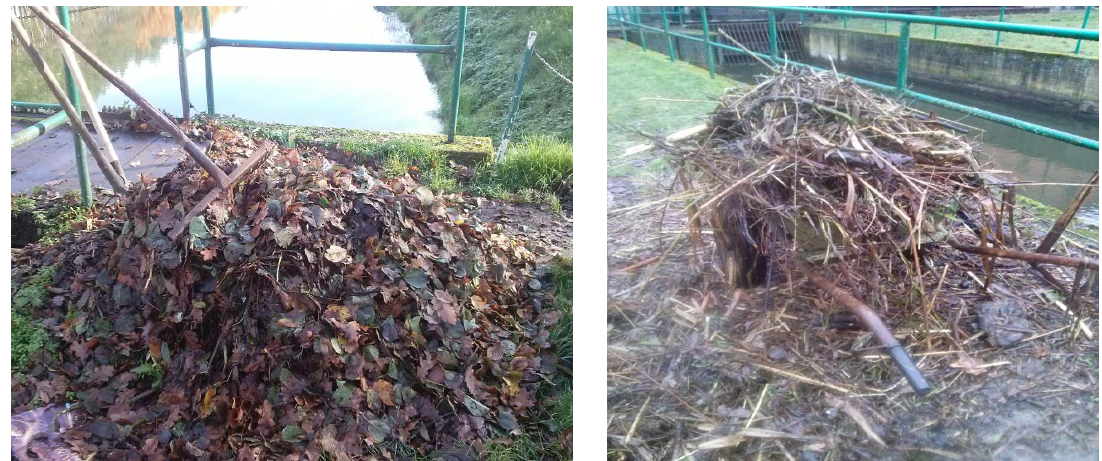
Figure 2. Plant debris collected from SHP trash racks (5 November 2014, 2 January 2015). Table 3. Weights of wet and dry plant debris for the Wełna River. Measurement